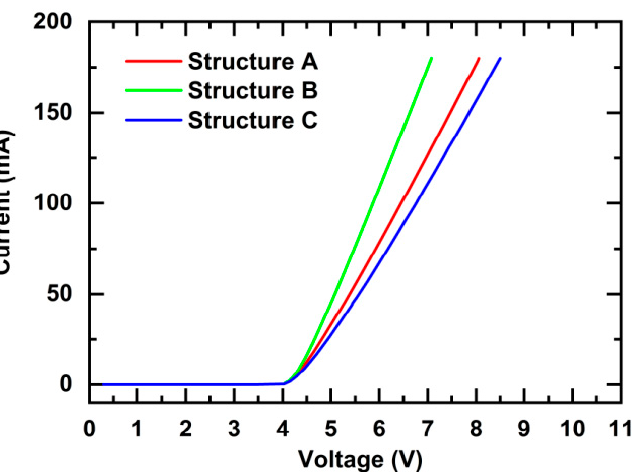
Figure 6. Comparison of the output I – V characteristics of LEDs (300 × 300 µ m 2 ) for Structures A, B, and C.